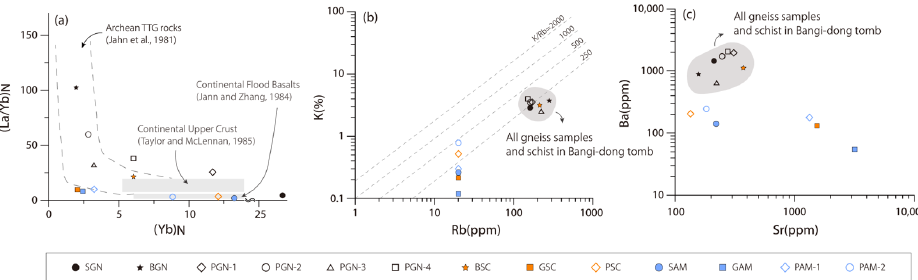
Figure 8. Geochemical plots of gneiss, schist, and amphibolite samples. Graphs ( a ) [20,29,30] and ( b ) are after Lee et al. (2004) and ( c ) shows the relation of Sr(ppm) and Ba(ppm). Sample names are as in Table